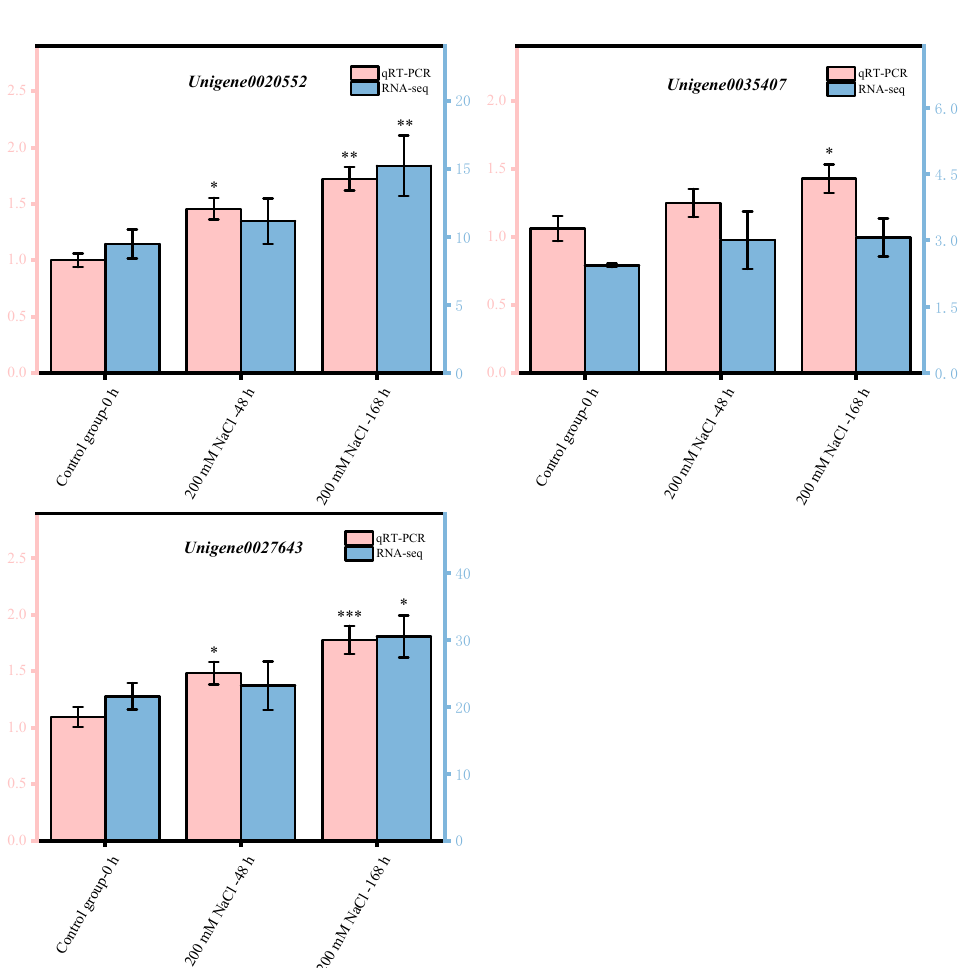
Figure 5. qRT-PCR validation of candidate key genes. (Nine candidate key genes were obtained based on antioxidant enzyme activity and gene expression in the flavonoid biosynthesis pathway. Note: p ≥ 0.05 is not marked; 0.01 < p < 0.05 is marked as *; 0.001 < p < 0.01 is marked as **; p ≤ 0.001 is marked as ***; red color: numerical value is shown on the left side of the Y axis; blue color: numerical value is shown on the right side of the Y axis).